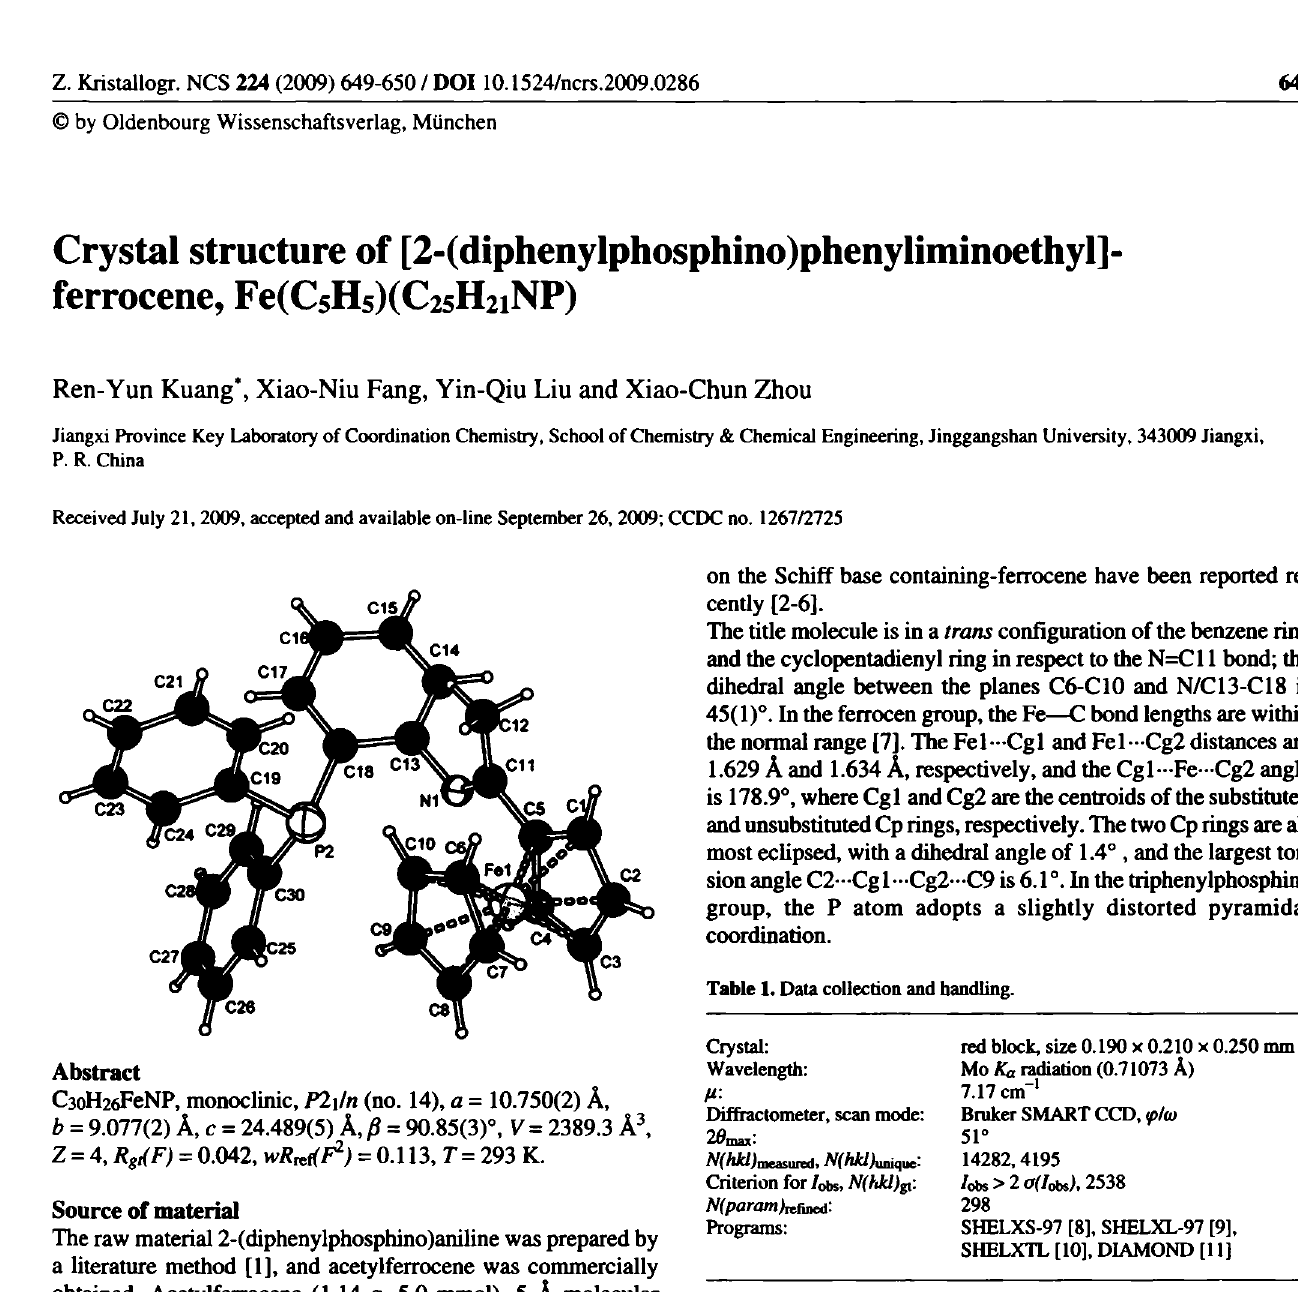
Table 2. Atomic coordinates and displacement parameters (in Ä 2